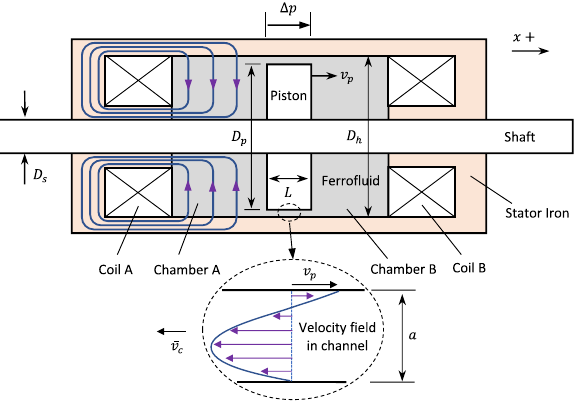
Figure 9. Bidirectional ferrofluid actuator showing magnetic flux lines and fluid flow due to current in coil A.